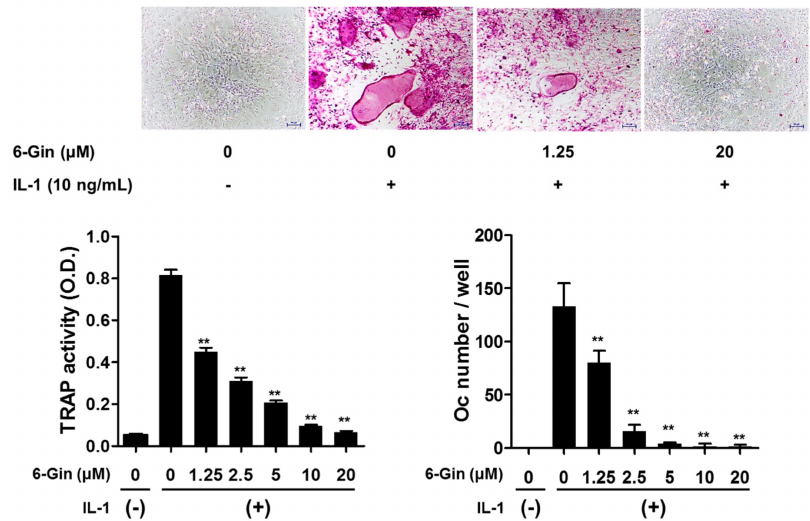
Figure 1. 6-Gingerol inhibits IL-1-induced osteoclast formation in co-cultures of primary mouse calvarial osteoblasts (POBs) and bone marrow cells (BMCs). The co-cultures were incubated with IL-1 (10 ng/mL) for seven days with 6-gingerol (6-Gin, 1.25–20 µ M) pretreatment 1 h prior to IL-1 treatment. After fixation, total cellular tartrate-resistant acid phosphatase (TRAP) activity was measured, and TRAP-positive multinucleated giant cells ( ≥ three nuclei, ≥ 50 µ m in diameter) were counted as osteoclasts. ** p < 0.01 vs. treatment with IL-1 alone. Scale bar = 100 µ m.